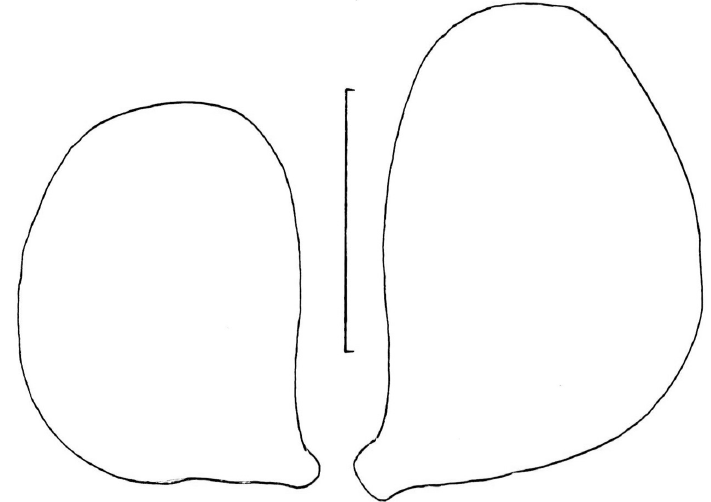
Figure 16. Mycetinis applanatipes . Basidiospores. Standard bars = 5 µm. DED 6628 (SFSU-F-